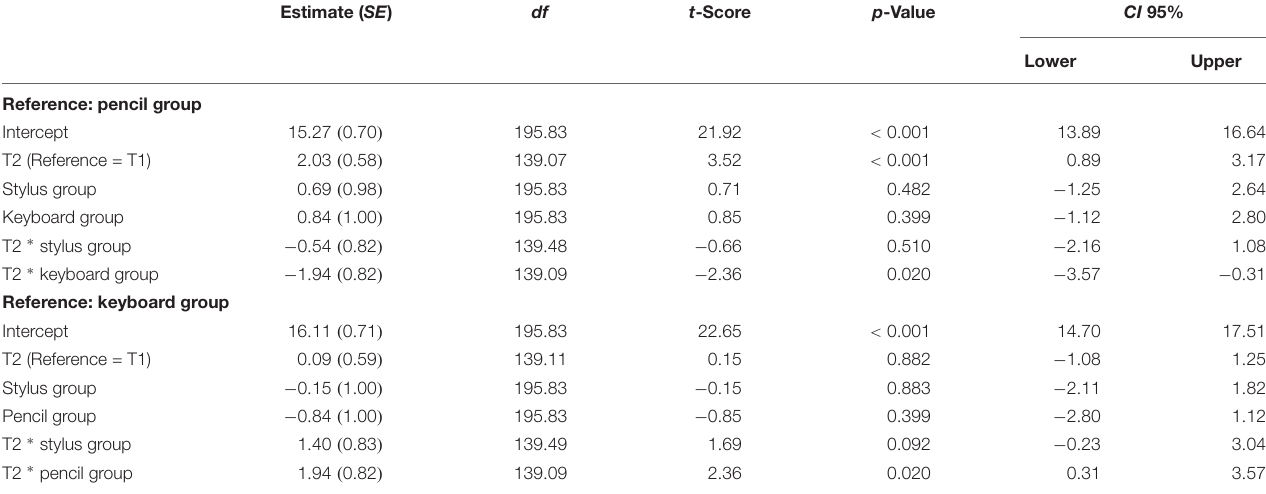
TABLE 7 | Results of estimated LMMs for the variable visuo-spatial skills to T1 vs. T2. Estimate ( SE ) df t -Score p -Value CI 95%